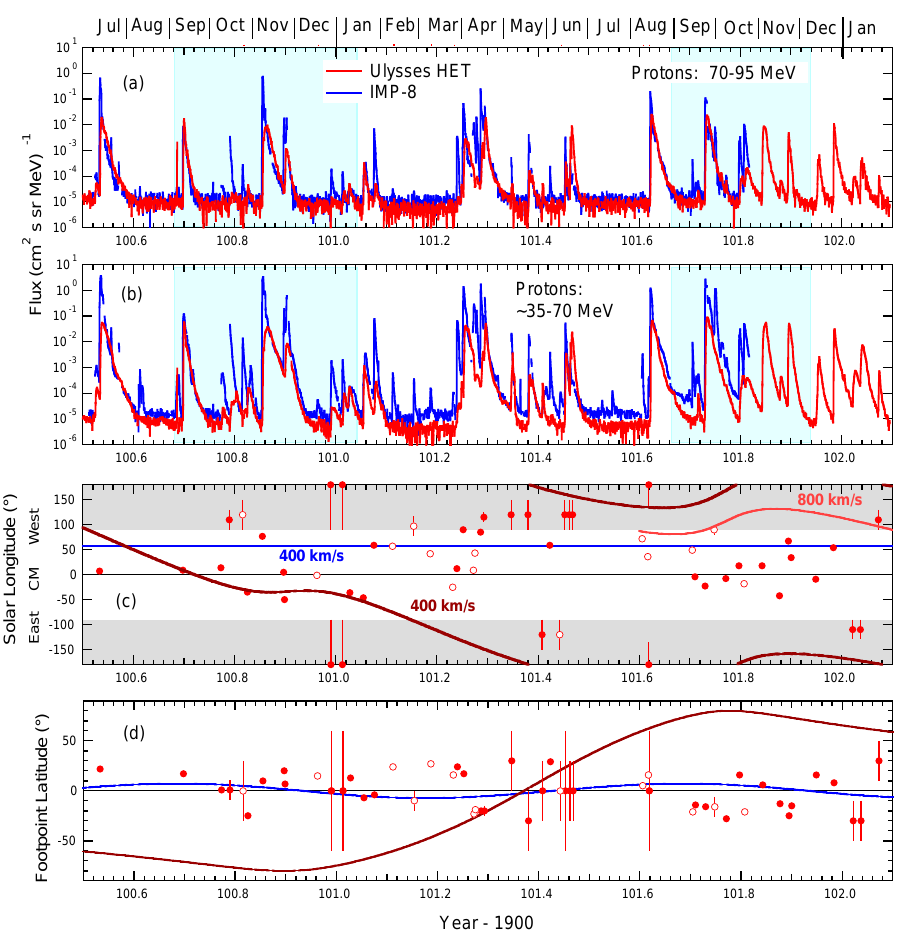
Fig. 5. (a)–(b) Fluxes of protons at energies of (a) ∼ 70–95MeV (a) and (b) ∼ 35–70MeV (see note on energy intervals in caption for Fig. 1c) measured at IMP (blue) and Ulysses (red) during the solar maximum polar passes and fast latitude scan. Light blue shading indicates the periods when Ulysses latitude was > 70 ◦ . IMP-8 operations were terminated after Day 253, 2001. (c) Locations in longitude with respect to central meridian observed from Earth of solar flares associated with Solar Energetic Particle events observed at IMP-8. Solid dots indicate events observed both at Ulysses and IMP. Open dots correspond to events producing particle increases observed only at IMP. Estimated uncertainties in the position are shown as error bars. Gray shading indicates the invisible hemisphere of the Sun. Flare locations on the invisible hemisphere are estimates based on any information available, including inferred position of active regions, observations of CMEs, radio emissions, etc. Red (or salmon) and blue curves show the location of the footpoints on the Sun of ideal Parker spiral field lines through IMP (blue) and Ulysses (red, salmon) for the solar wind velocities indicated. For IMP and Ulysses through the middle of 2001, slow solar wind ( ∼ 400km/s) dominated. After the middle of 2001, Ulysses began to observe fast polar coronal hole solar wind ( ∼ 800km/s) during certain intervals. The salmon curve indicates the footpoint position for 800km/s solar wind. The actual footpoint position thus should lie on or between the 400 and 800km/s curves. (d) Same as (c) for the latitudinal positions of the solar flares associated with SEP events observed at IMP-8. Solar wind velocity does not affect footpoint positions in latitude for the classical Parker spiral